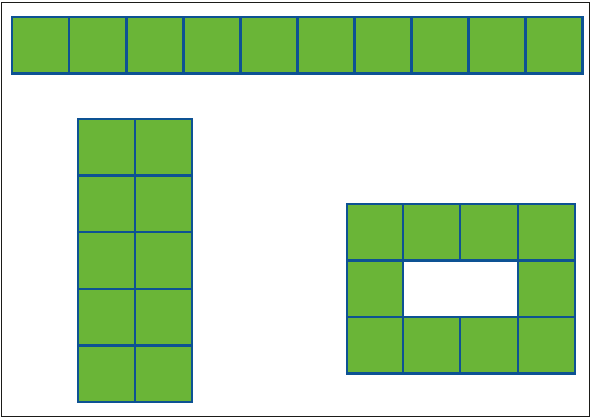
Figure 2: Eight tiles—two rectangles with no